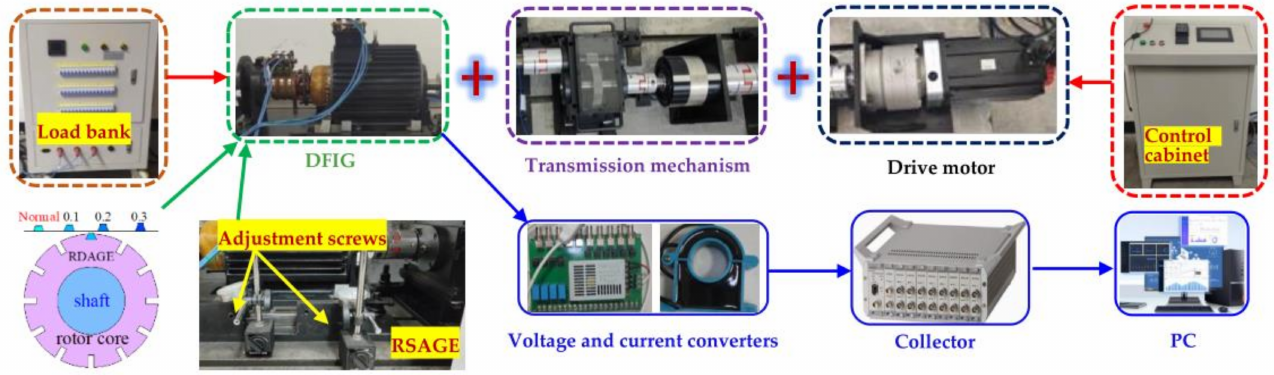
Figure 5. FEA model: ( a ) DFIG two-dimensional model; ( b ) external circuit model.